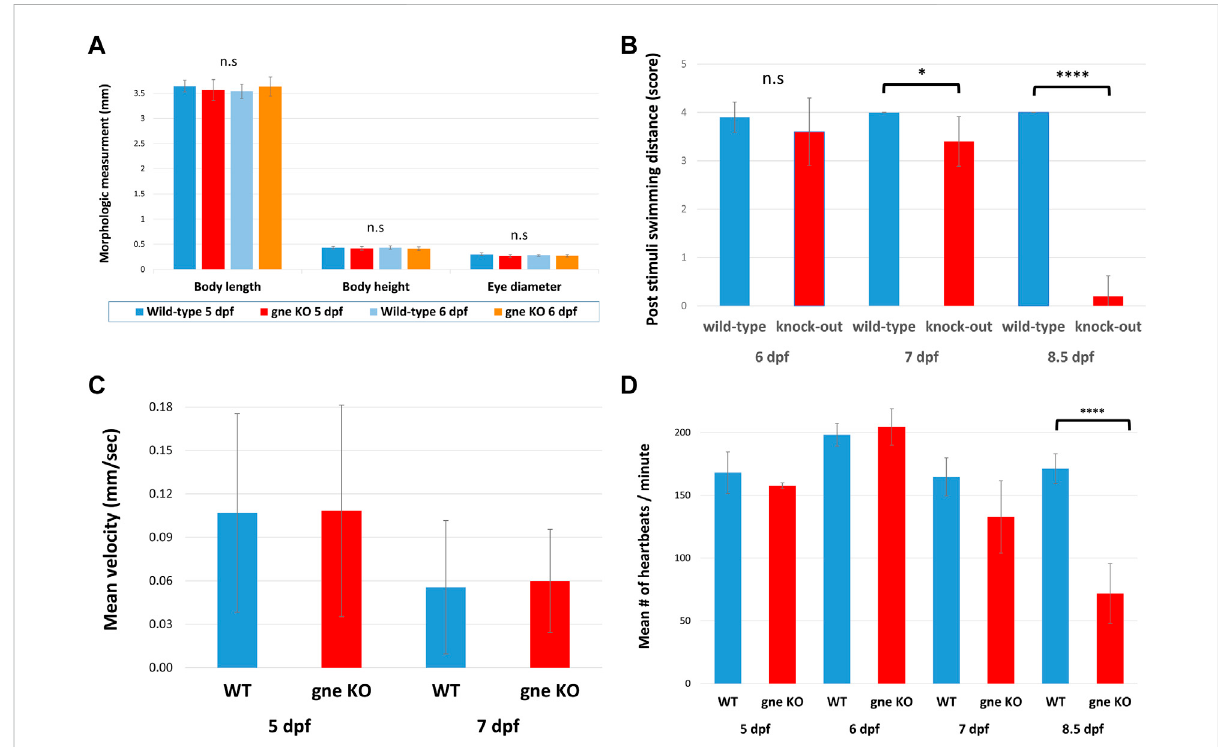
FIGURE 3 Structural and functional characterization of the gne knockout larvae. (A) Analysis of morphologic measurements (body length, body height, eye diameter) in gne − / − mutants and WT larvae at 5 and 6 dpf did not show any statistically signi fi cant differences (Mann-Whitney Wilcoxon test, n = 40, p > 0.05). (B) gne KO larvae display reduced response to tactile stimuli in ’ Touch-evoke assay ’ . Quanti fi cation of the assay revealed that gne KO larvae swim signi fi cantly less distance, compared to WT larvae, following tactile stimuli at 7 and 8.5 dpf (Mann-Whitney Wilcoxon test, n = 60). (C) Locomotor activity is not affected in gne KO larvae relative to their WT sibling. The mean velocity was calculated for each larva for 60 min, then averaged for each gne genotype at 5 and 7 dpf. (Mann-Whitney Wilcoxon test, n = 133). (D) Zebra fi sh gne KO heartbeat rate is signi fi cantly